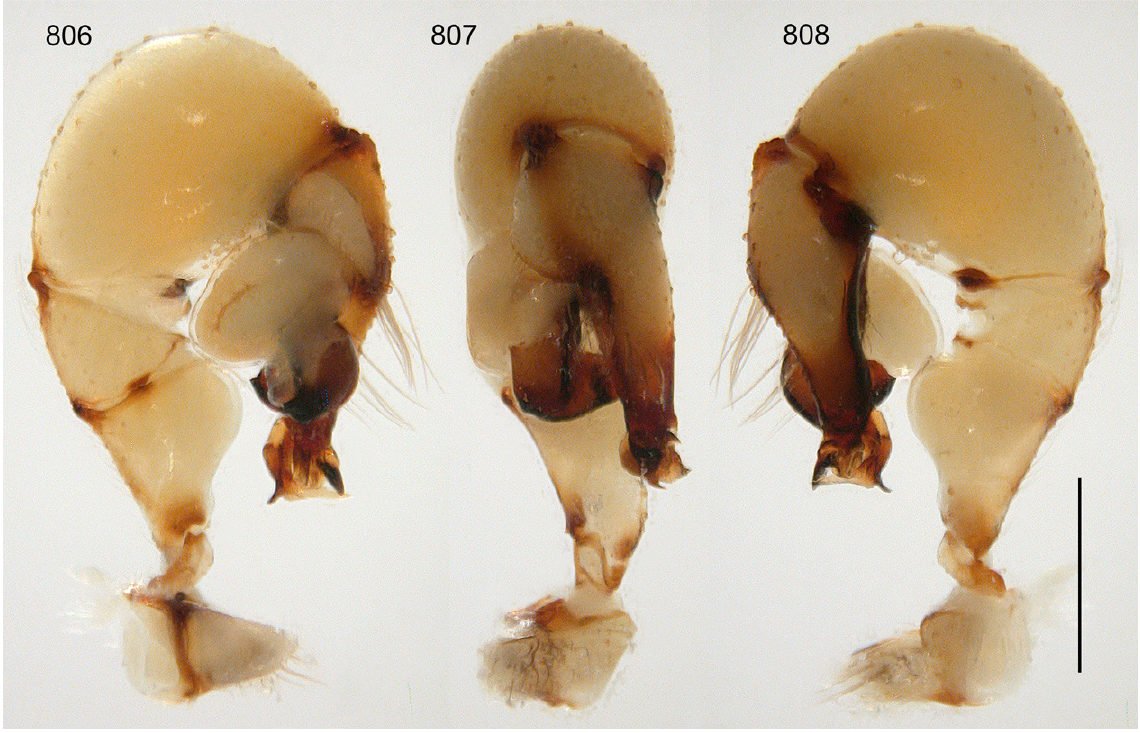
Figs 806–808. Crossopriza surobi sp. nov.; non-type male from Afghanistan, SE of Surobi (MHNG); left palp, prolateral, dorsal, and retrolateral views. Scale bar = 0.5